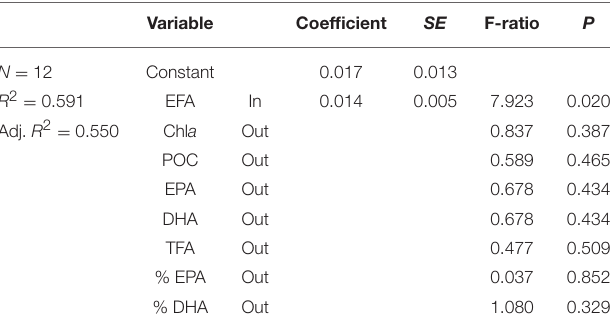
TABLE 3 | Multiple regression coefficients and their significance for the model describing factors affecting the growth rate of nauplii [growth = constant + EFA (mg g − 1